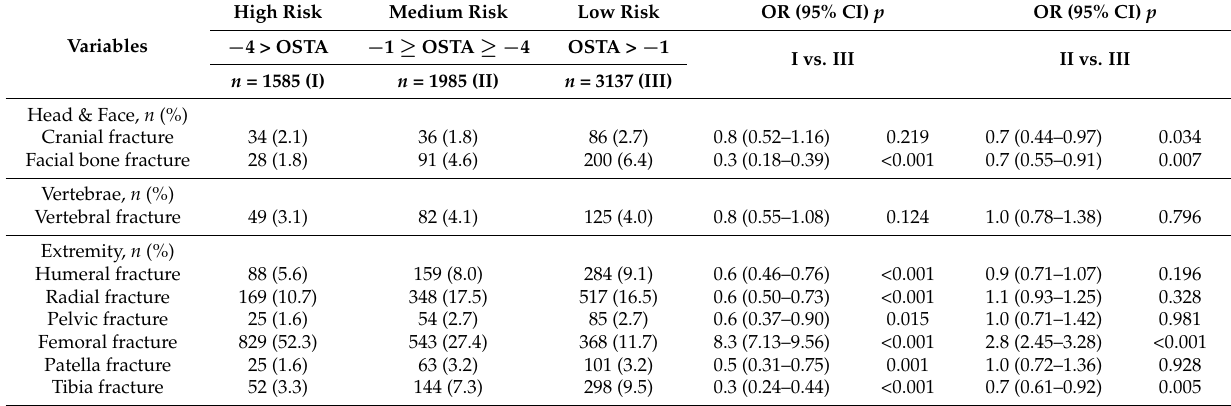
Table 3. Associated fracture sites in high-risk (OSTA < − 4), medium-risk ( − 1 ≥ OSTA ≥ − 4), and low-risk (OSTA > − 1) patients.